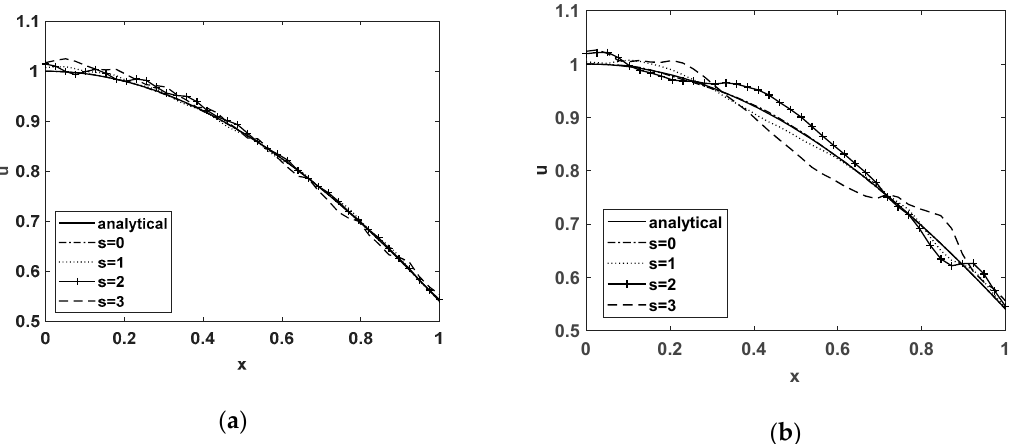
Figure 5. Comparison of numerical solutions along missing boundary obtained by various s on the boundary conditions: ( a ) uniform discretization; ( b ) non-uniform discretization.